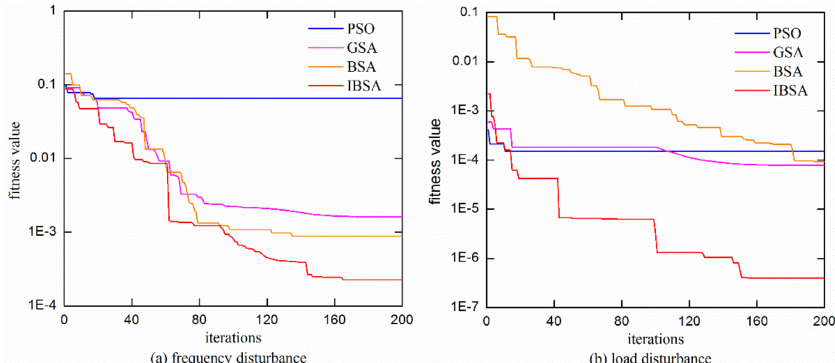
Figure 9. Convergence curves of different optimization algorithms under the frequency and load disturbances.